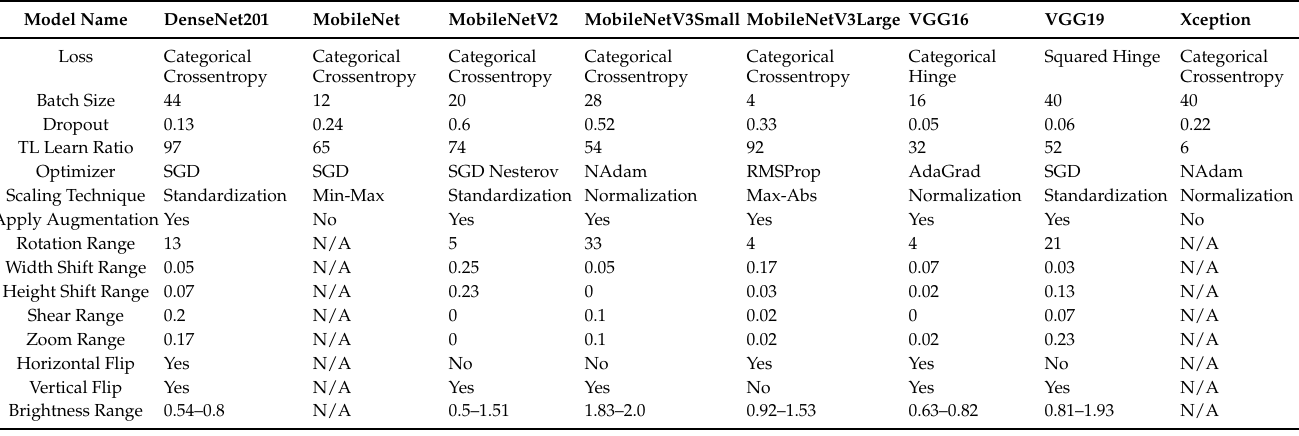
Table 5. The best hyperparameters for each pretrained CNN model using the “Alzheimer’s Dataset (4 class of Images)” dataset.